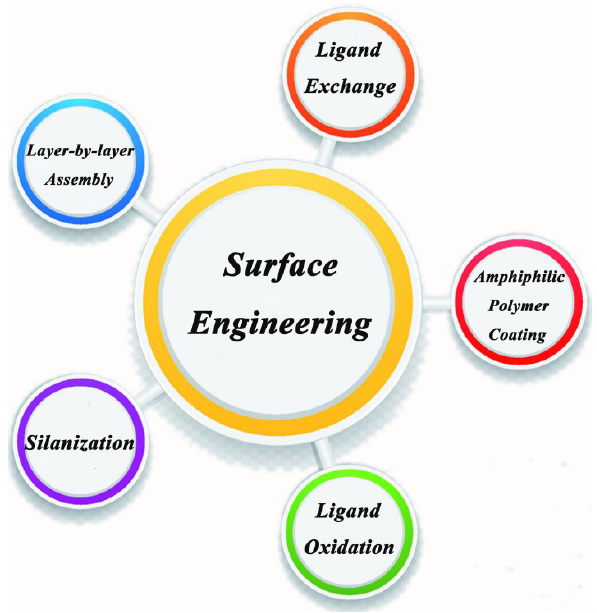
Fig. 3. Schematic illustration of general strategies for surface engineering of